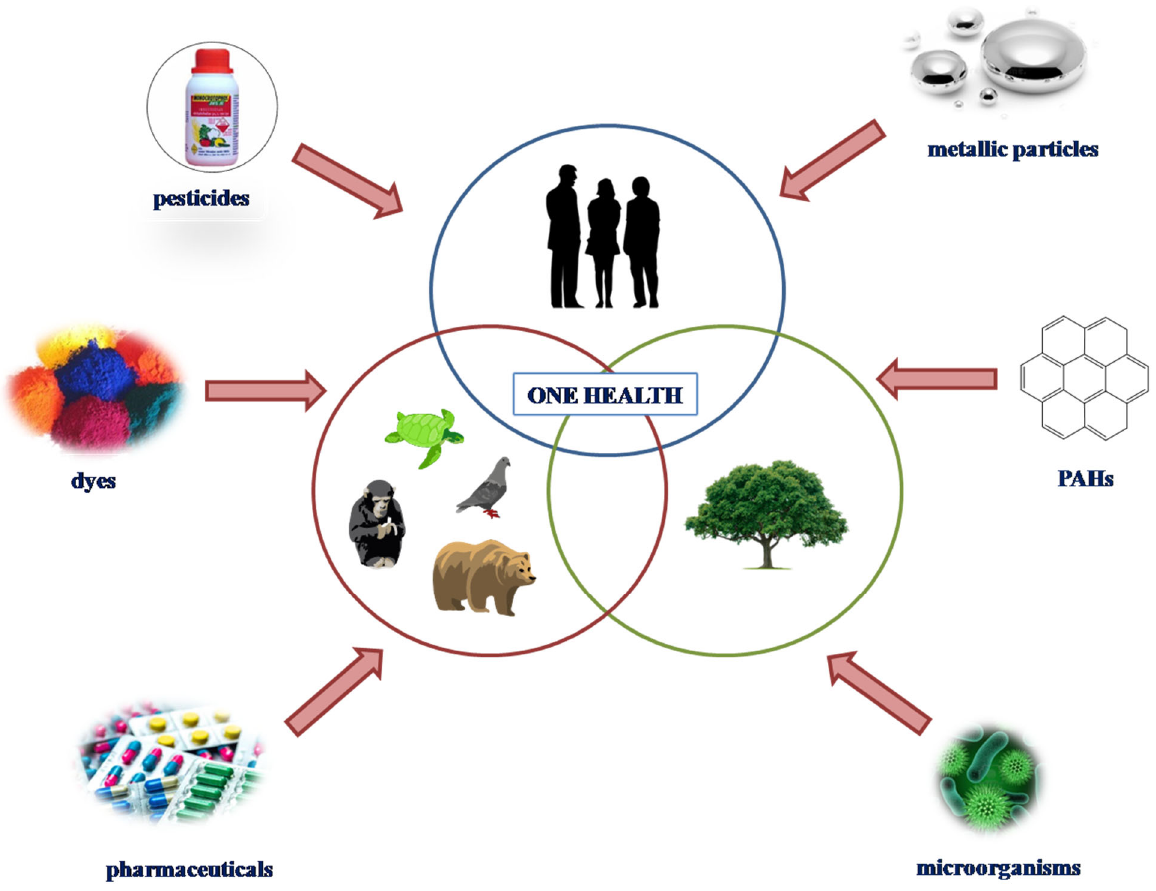
Figure 1. Schematic representation of the One Health principle.